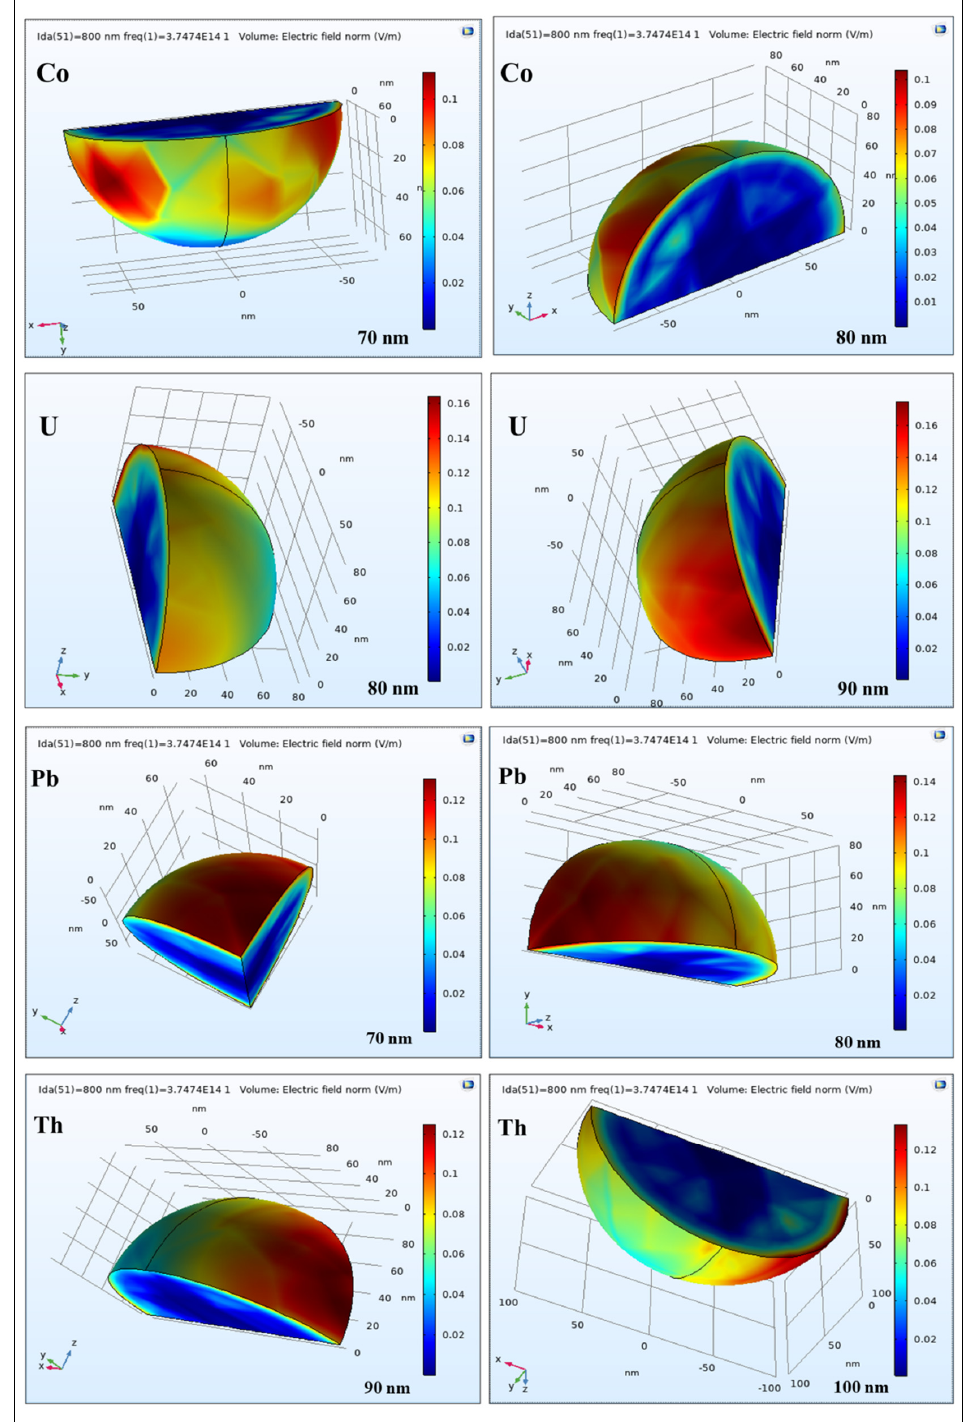
Figure 4. 3D plots of U, Pb, Co, and Th nanoparticles from diverse sizes produced via COMSOL, where the color scale illustrates the amplitude of H ‐ field or E ‐ field. The simulated absorption spectra of U, Pb, Co, and Th nanoparticles of diverse sizes obtained with COMSOL are given in Figure 5, respectively, while simulated maximum